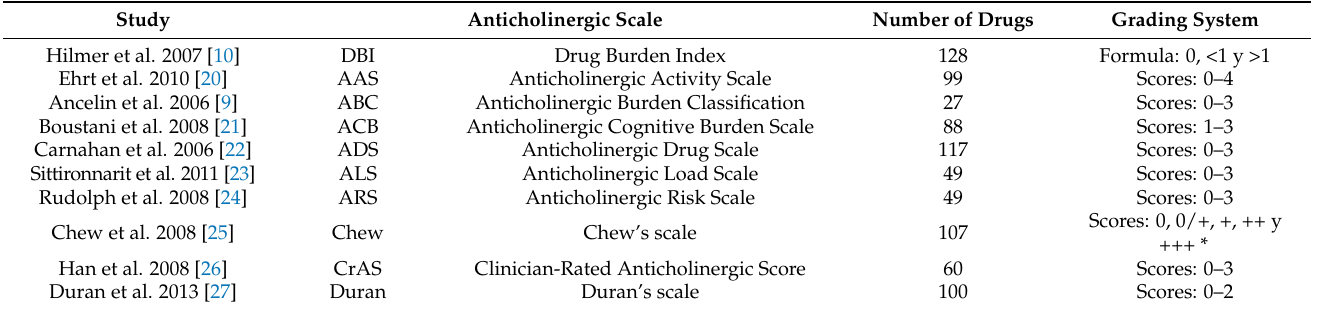
Table A2. Information about the scales included in the Anticholinergic Burden Calculator (www. anticholinergicscales.es/)